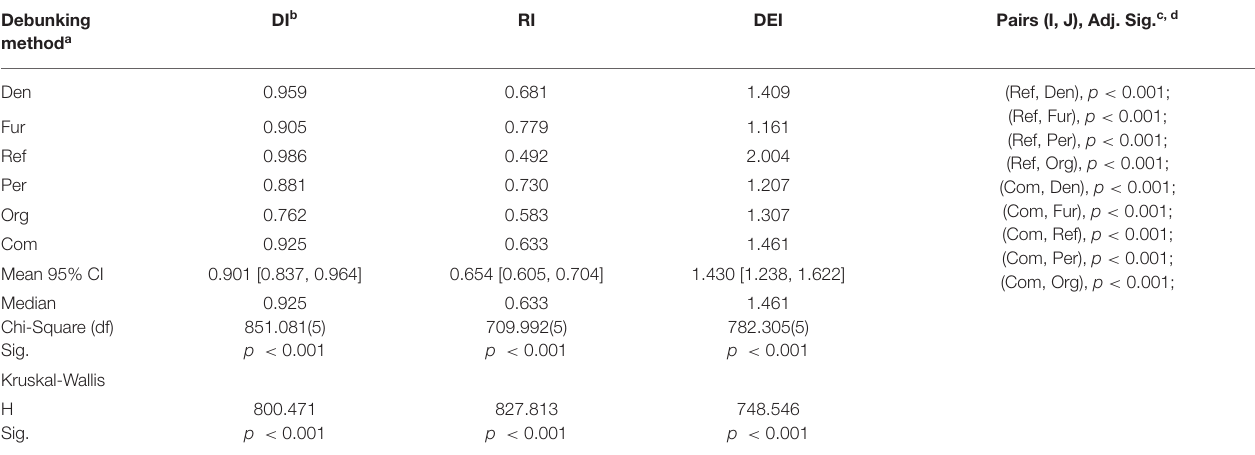
TABLE 5 | Comparison of DEI under different debunking methods. Debunking method a